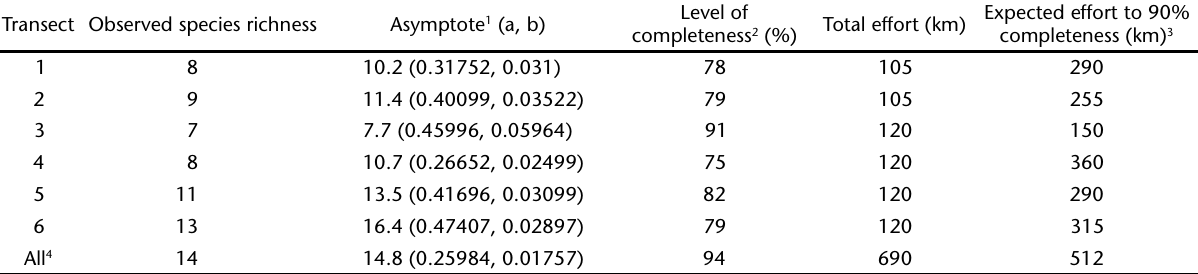
1 Expected number of species; calculated as a/b. 2 Percentage of species recorded as a function of the asymptote. 3 Estimated sampling effort required to reach survey completeness (90% of the asymptote, see Methods). 4 All transects pooled (landscape level).